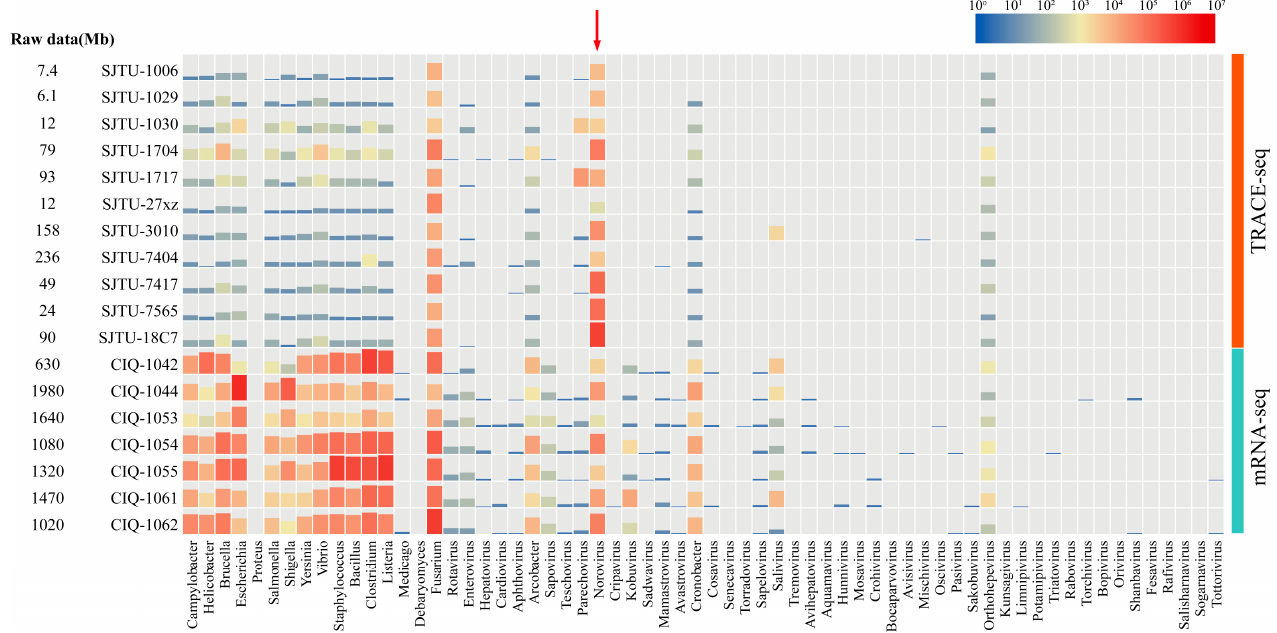
Figure 3. Species distribution heatmap of effective reads of the TRACE-seq method and mRNA-seq method. Samples are listed by the left side, the main food-borne pathogenic microorganisms are listed in abscissa. The effective reads number of each pathogen are shown by the height of column and color from blue to red by the increase of the reads number. The relationship between the effective reads number and the related color is shown on the upper right site. Reads of norovirus are pointed to with a red arrow.